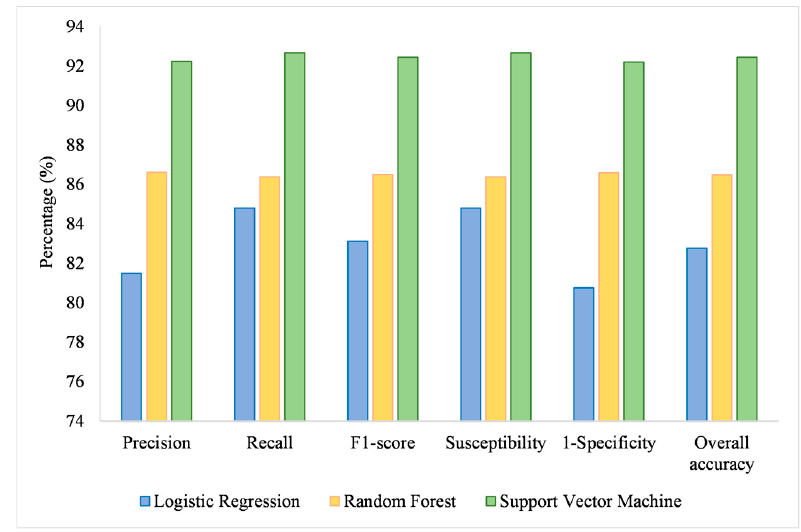
Figure 8. Comparison of model accuracy.